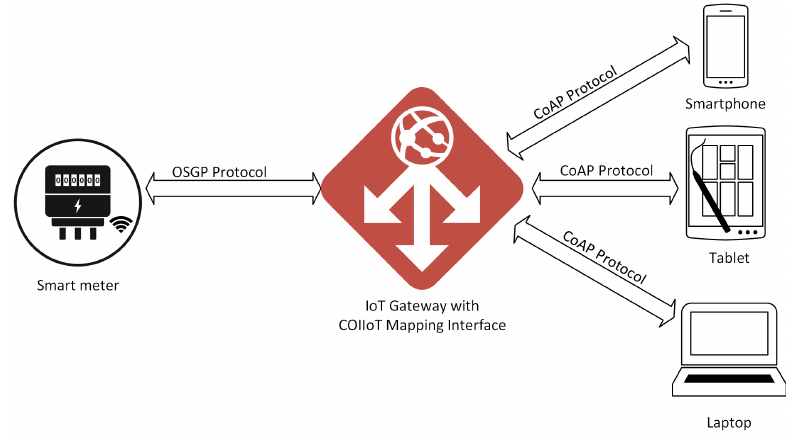
Figure 6. Example of a COIIoT-based